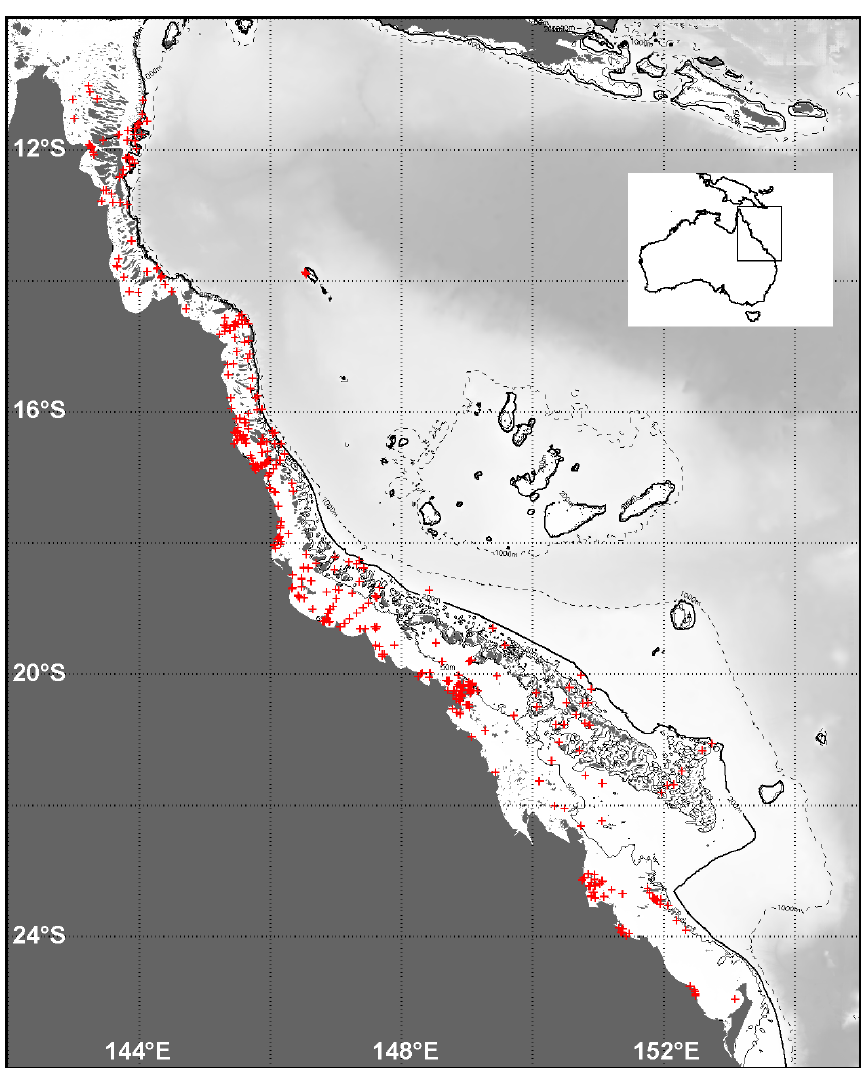
Figure 1. Map of Secchi depth measurement locations (red) in the Great Barrier Reef from 1994 to